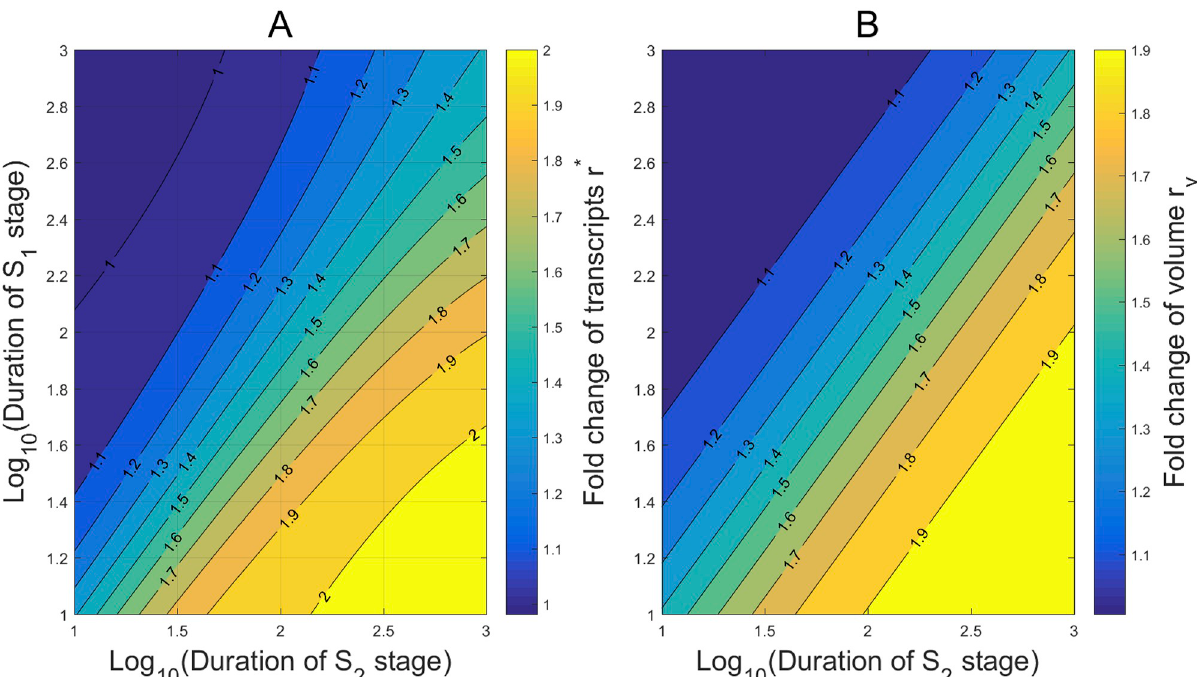
Fig 7. The transcript concentration homeostasis by reducing the transcription burst frequency in G 2 phase. The burst frequency λ 2 is reduced from 0.5556 in (51) to 0.3445, and other kinetic rates are taken from (51). (A) The contours of the fold change r � for the mean transcription levels from S . (B) The contours of the fold change r for the volumes from S to S . The two sets of contours in (A) and (B) display a large similarity, indicating S v 2 1 2 that the transcript concentration homeostasis is almost reached by reducing the frequency uniformly over most area of the stage